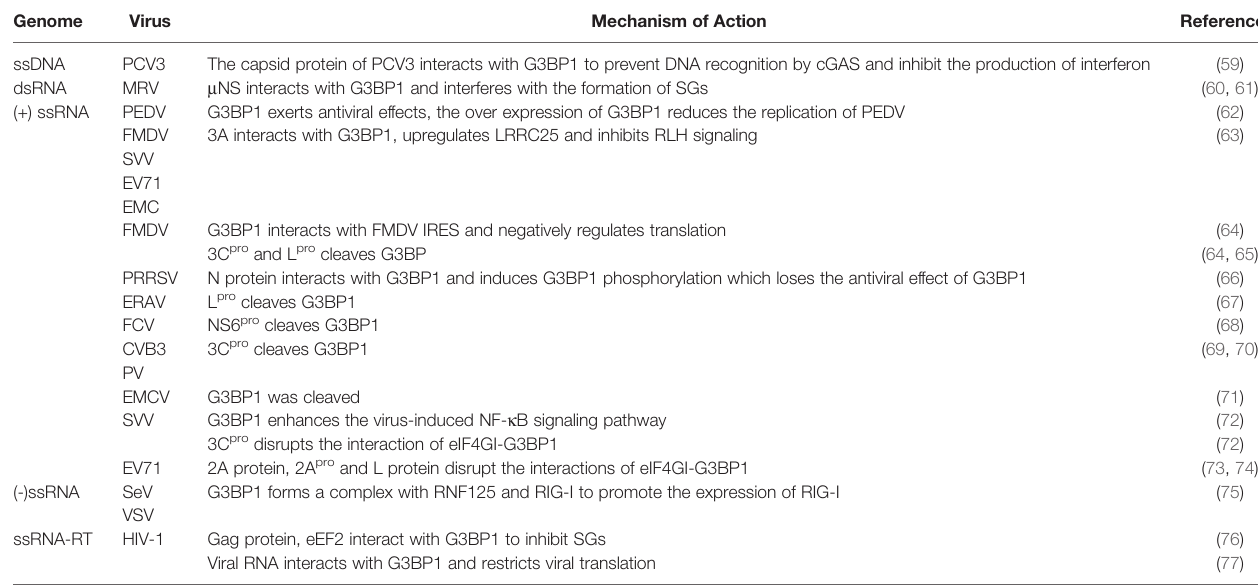
TABLE 1 | G3BP inhibits viral